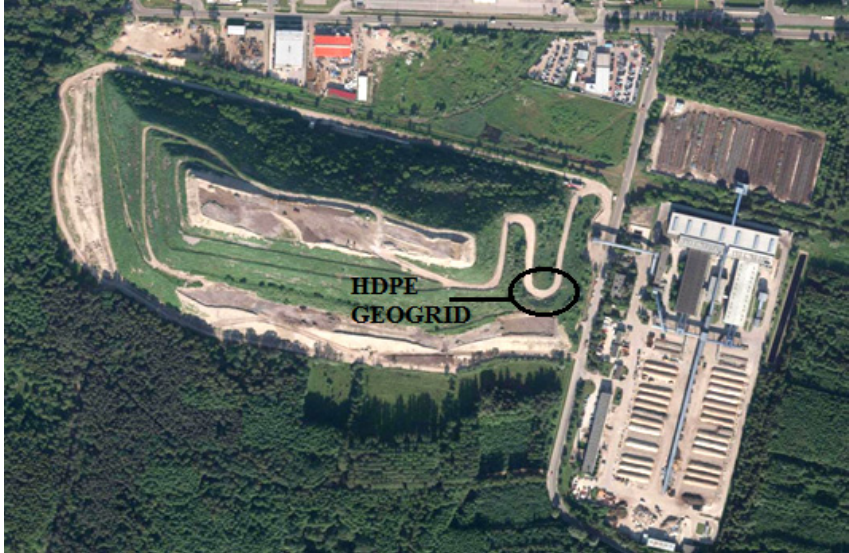
Figure 1. View of the Radiowo landfill where the northern and western slopes were reinforced by a high density polyethylene (HDPE) geogrid in 1993.